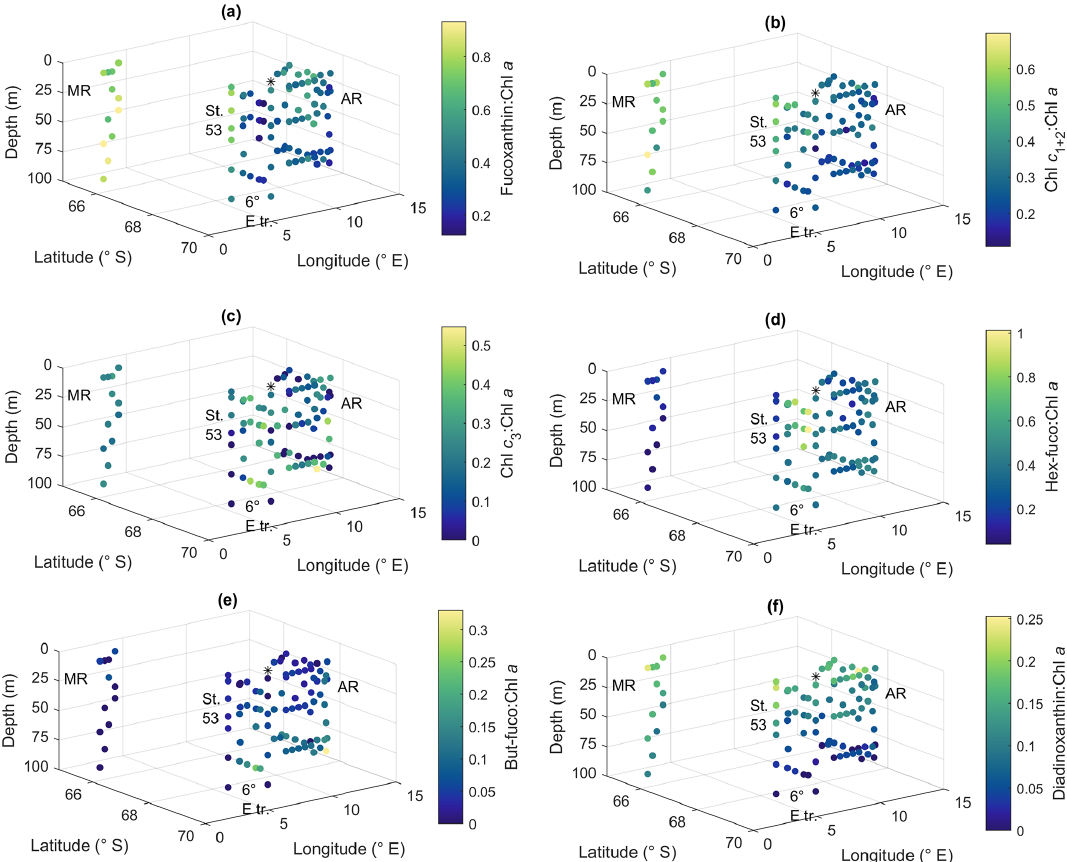
Figure 9. Ratios of algal pigments to Chl a for (a) fucoxanthin, (b) Chl c 1 + 2 , (c) Chl c 3 , (d) hex-fuco, (e) but-fuco and (f) diadinoxanthin. MR: Maud Rise, St. 53: station 53, AR: Astrid Ridge, 6 ◦ E tr.: 6 ◦ E transect. Station 54 is marked with a black